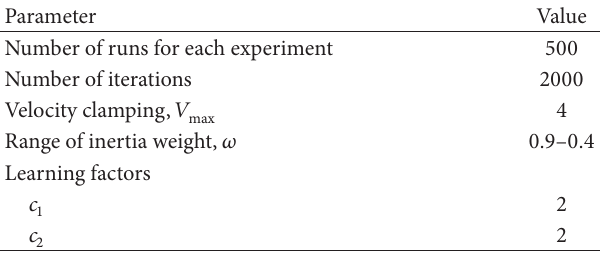
Table 1: Parameters setting for S-PSO, A-PSO, and